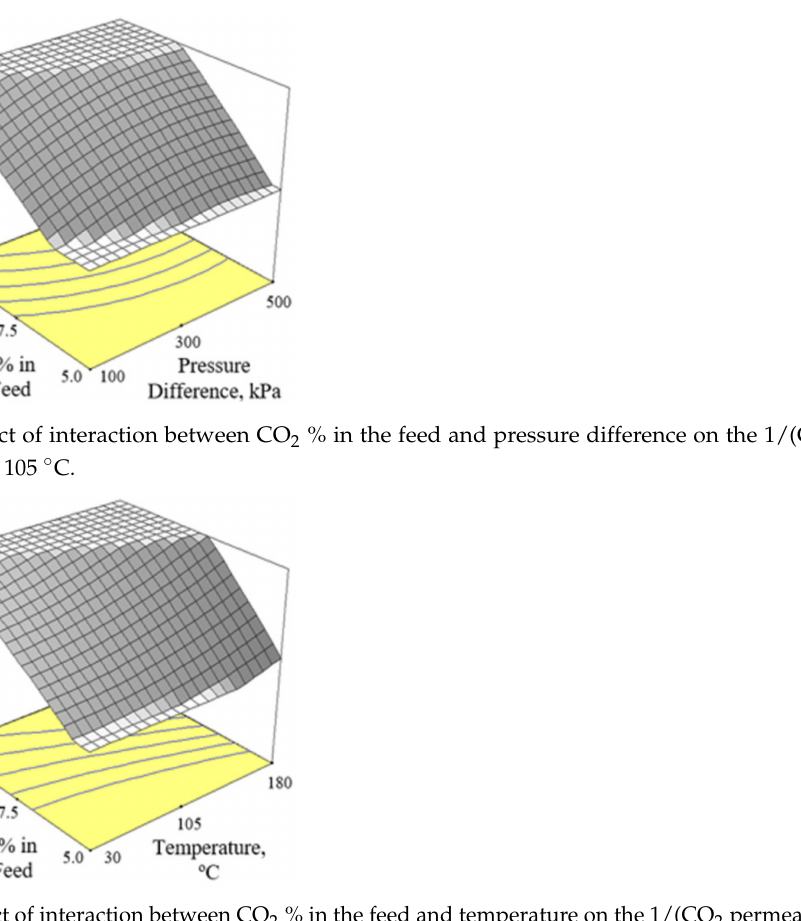
Figure 4. Effect of interaction between CO 2 % in the feed and temperature on the 1/(CO 2 permeance) at 300 kPa pressure